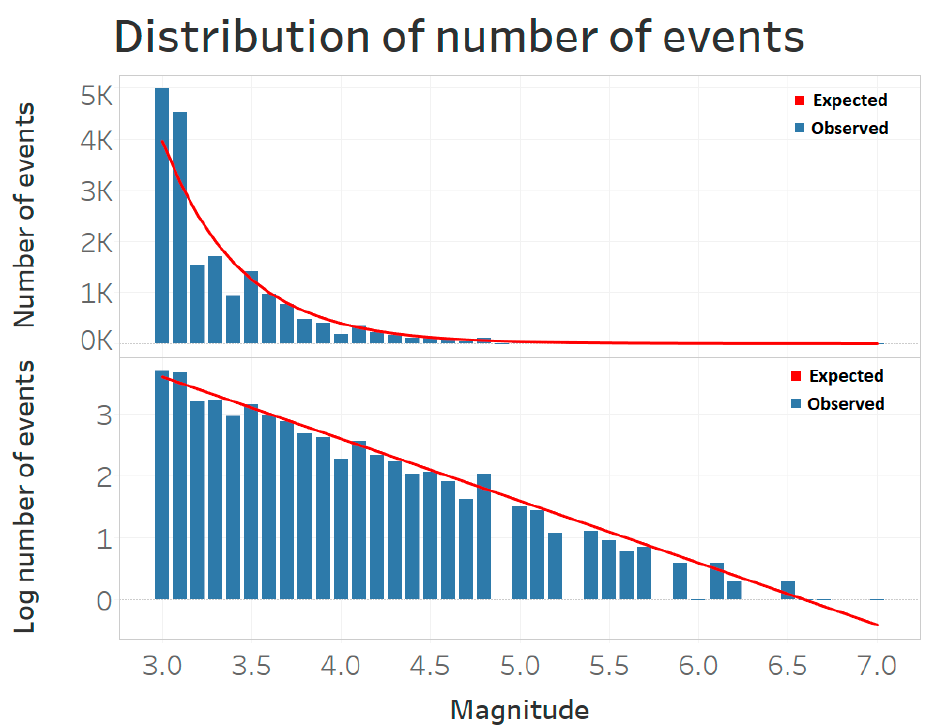
Figure 4. Distribution of the number of events. The blue bars in the top figure show the number of events for each magnitude and the red line is the number of events corresponding to the Gutenberg–Richter law. In the bottom figure, the logarithm base 10 of the same data is shown. If the magnitude distribution follows the Gutenberg–Richter law, the blue bars in the bottom figure should correspond to the red line.